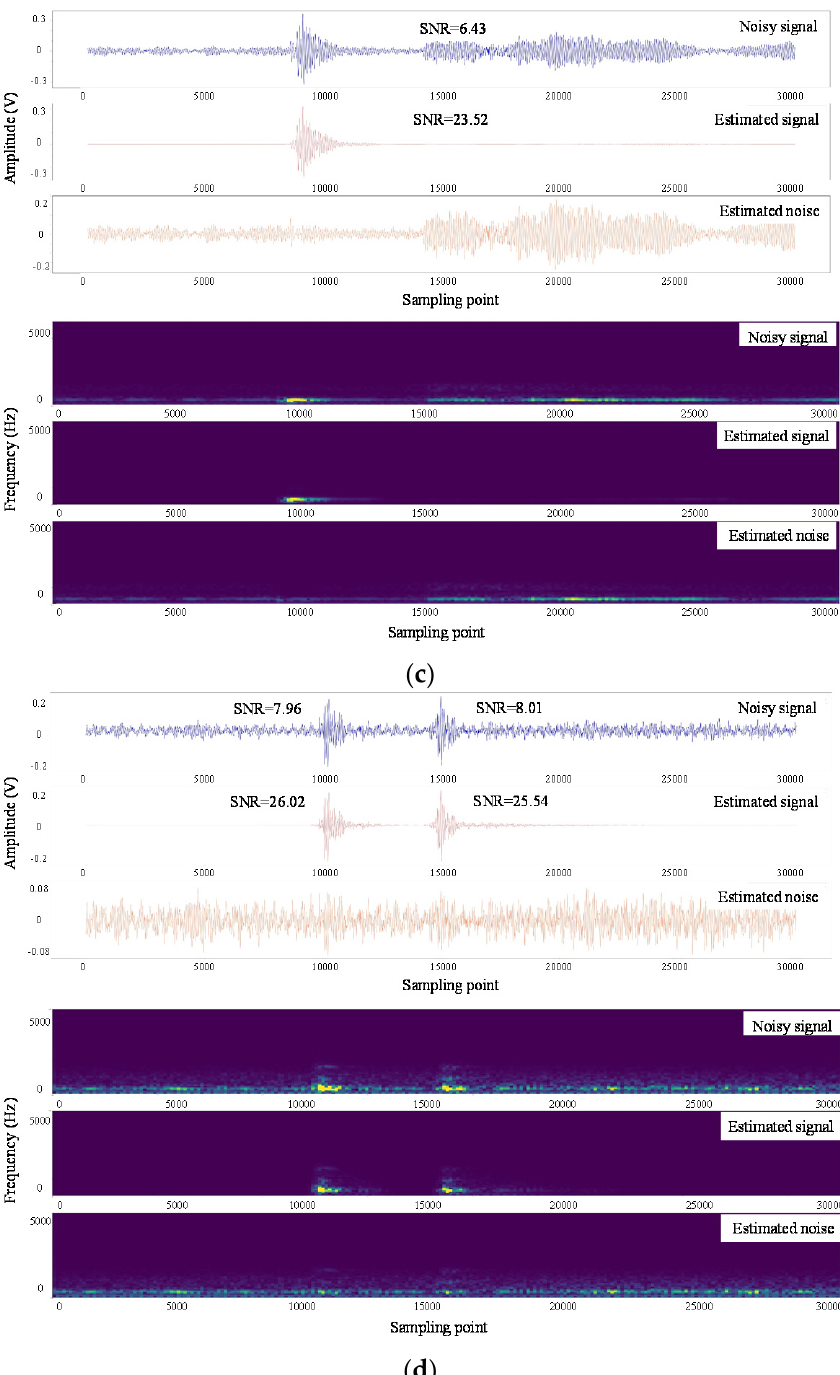
Figure 6. Denoising examples of different recorded noisy signals in Zijing tunnel (China). The signals in the time domain and time–frequency domain are noisy signal, estimated signal, and estimated noise from top to bottom of each sub-figure. ( a , b ) Microseismic signals with cyclic noises at different frequency; ( c ) microseismic signal with a mixture of cyclic noise and other noise; ( d ) noisy signal contains more than one microseismic waveform.